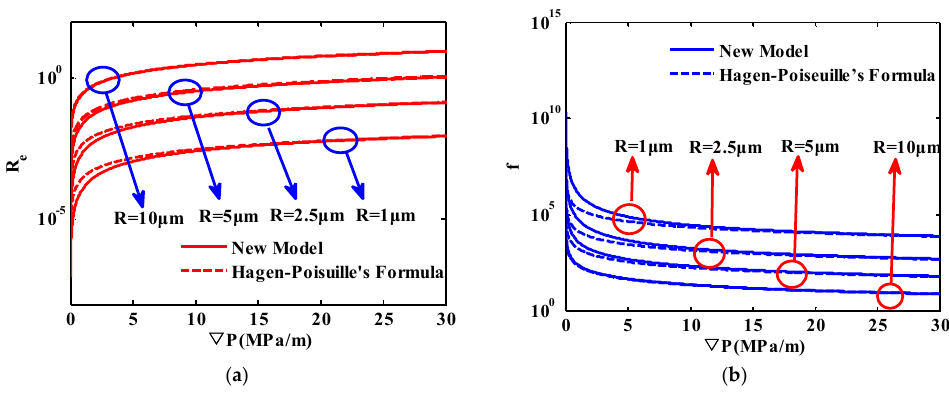
Figure 13. Relationships of R e and f versus ∇ P : ( a ) R e versus ∇ P ; ( b ) f versus ∇ P.